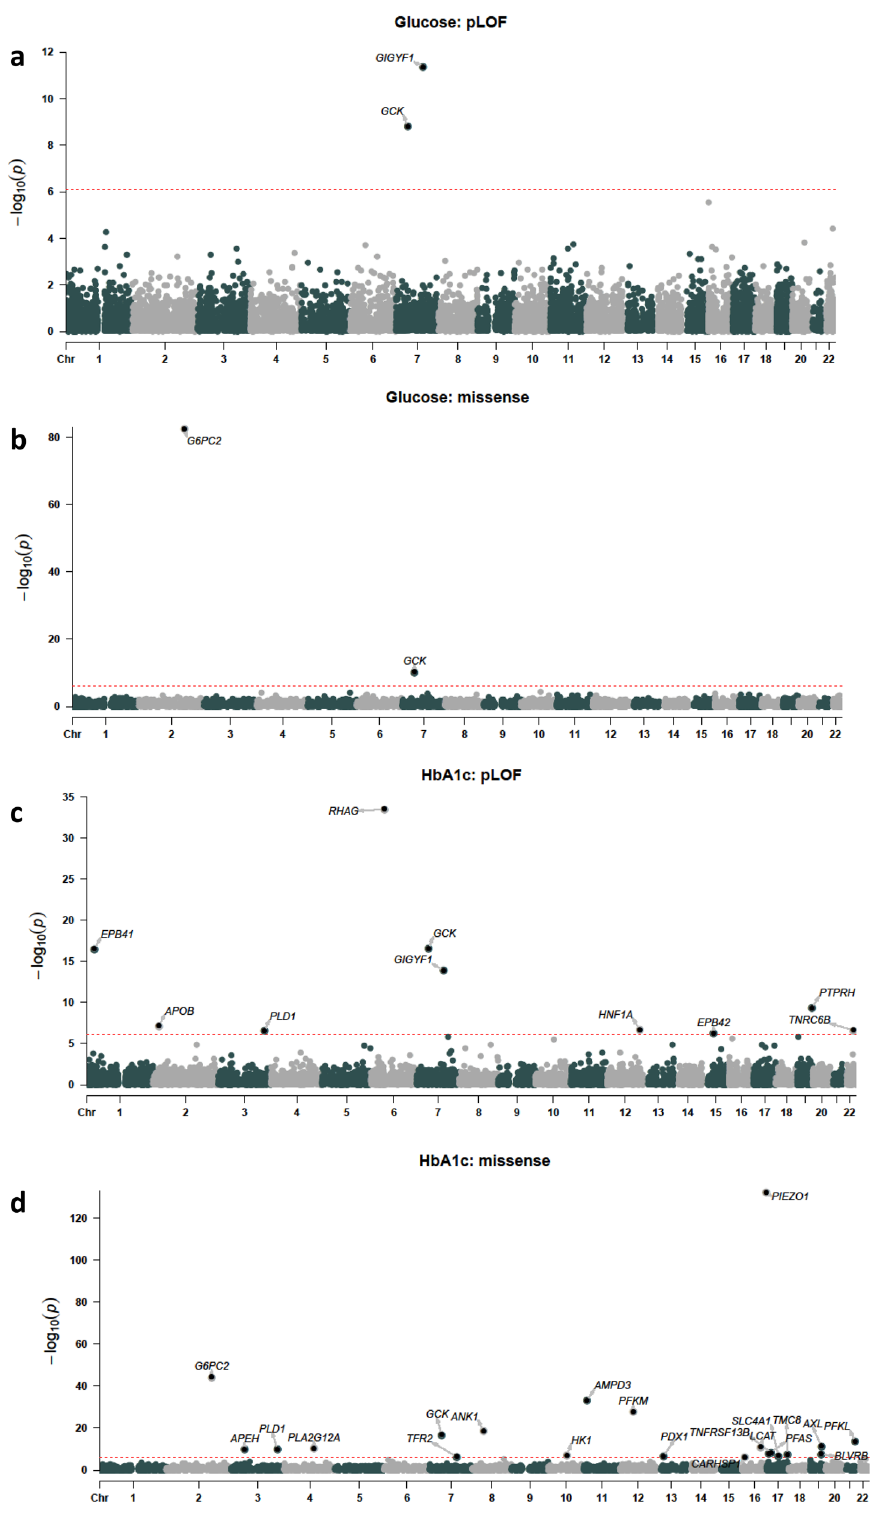
Figure 1. Gene-level associations with glucose and HbA1c levels. ( A ) pLOF associations with glucose levels. ( B ) Damaging missense variant (CADD score ≥ 25) associations with glucose levels. ( C ) pLOF associations with HbA1c. ( D ) Damaging missense variant associations with HbA1c levels. The red line indicates the threshold for significance, genes with significant associations are